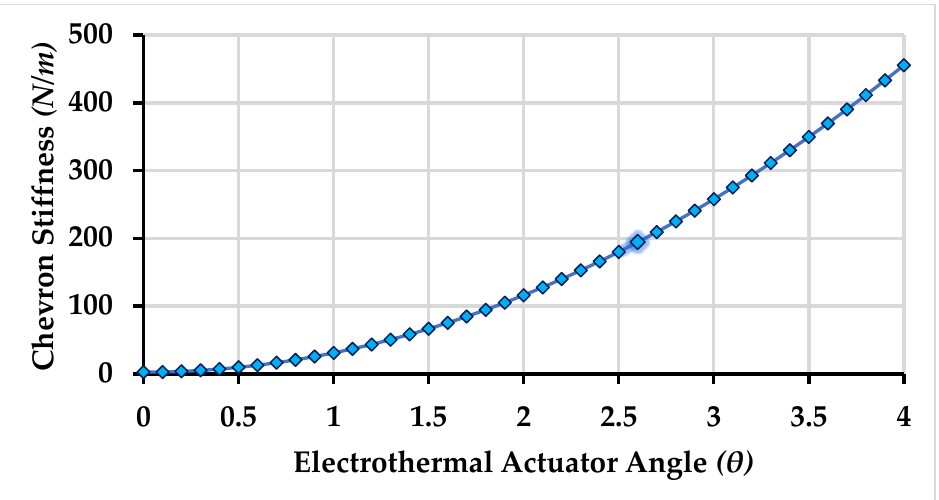
Figure 5. Stiffness values of the electro-thermal actuator with angle variations.